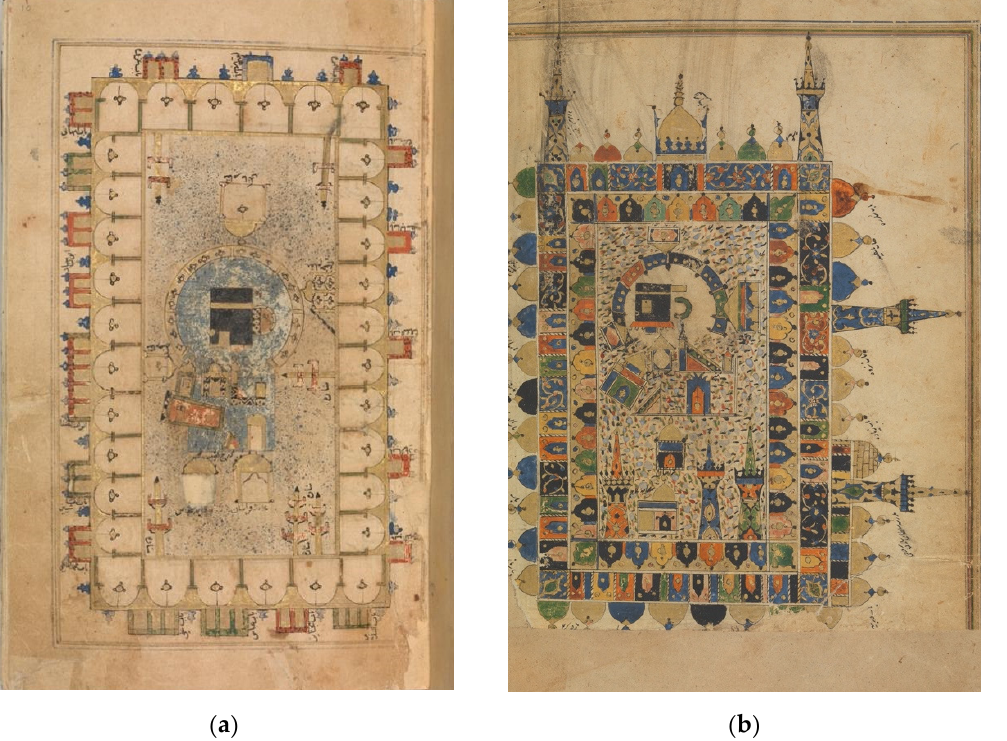
Figure 2. ( a ) Illustration of al-Majid al-Haram, Fut ū ḥ al- Ḥ aramayn , mid-16th century. The Metropolitan Museum of Art, 32.131, 10r. photo in public domain. ( b ) Illustration of al-Majid al-Haram, Fut ū ḥ al- Ḥ aramayn , late-16th century. The Metropolitan Museum of Art, 2009.343, p. 40. photo in public domain.